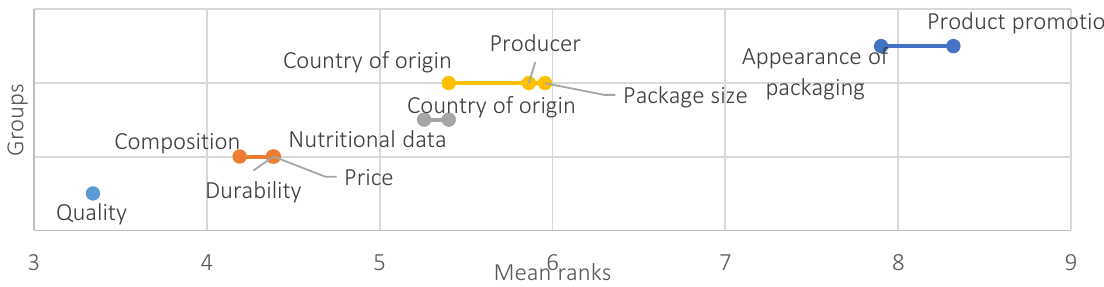
Figure 8. Differences in the assessment of factors determining the level of consumption of milk and dairy